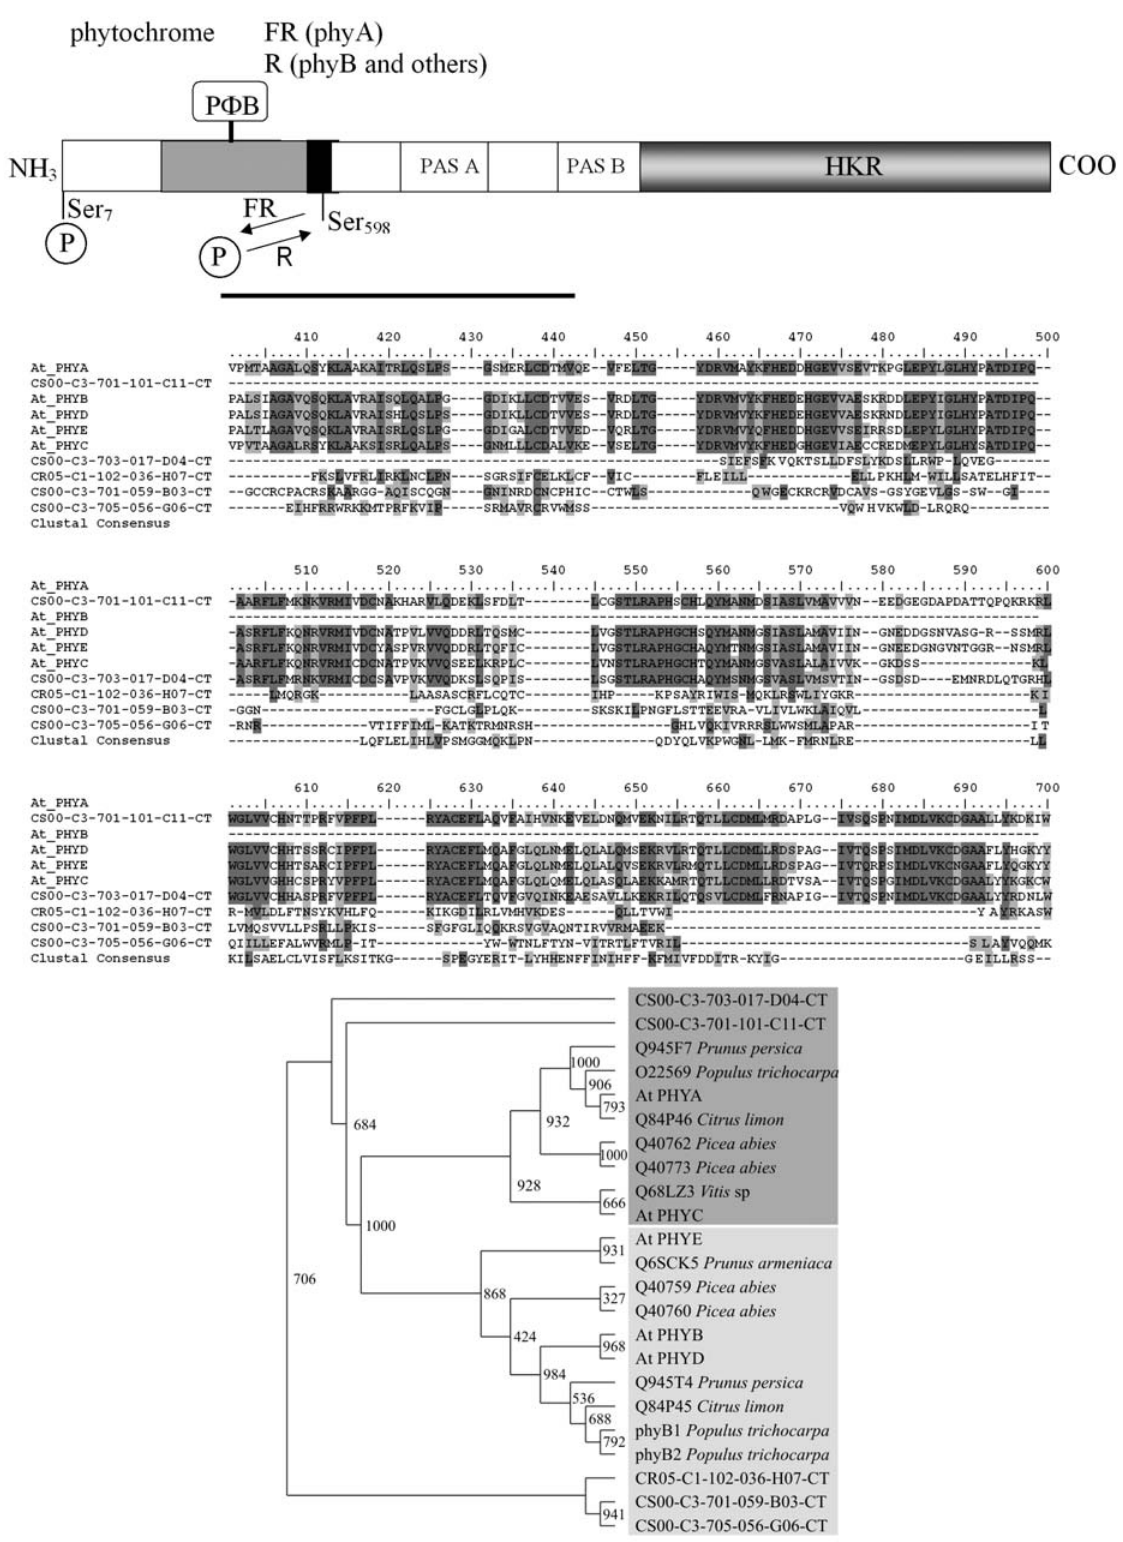
Figure 2 - Domain structure, phylogenetic analyses and alignment of the predicted amino acid sequence of phytochrome family in citrus. Neigh- bor-joining trees for citrus and tree species deduced amino acid and Arabidopsis full length sequences aligned with ClustalX are shown. Bootstrap values areindicatedaboveeachbranch.Darkandlightgrayshadingindicatesequenceidentityandsimilarity,respectively.At, Arabidopsisthaliana ;CNumber, contig number; Cit, citrus; CS, Citrus sinensis ; CR, Citrus reticulata ; FAD, flavin adenosine diphosphate; FR, far-red light; HKRD, histidine kinase-related domain; PAS, Per-ARNT, Sym domain; P Φ B, phytochrome bilin; R, red light; ser, serine